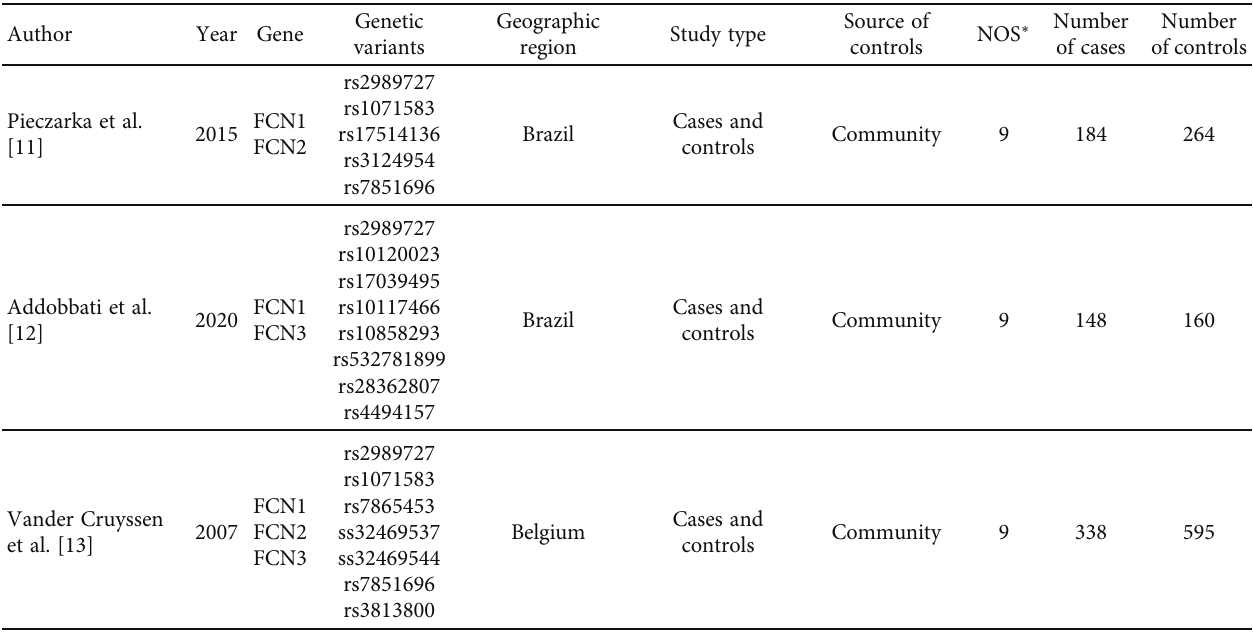
Figure 1: Flow chart of literature screening. Table 1: Data from studies included in the systematic